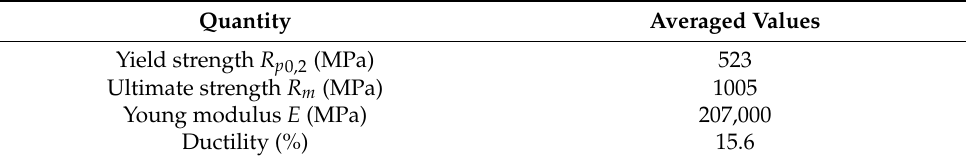
Table 1. Mechanical properties of 51CrV4 material obtained from the tensile